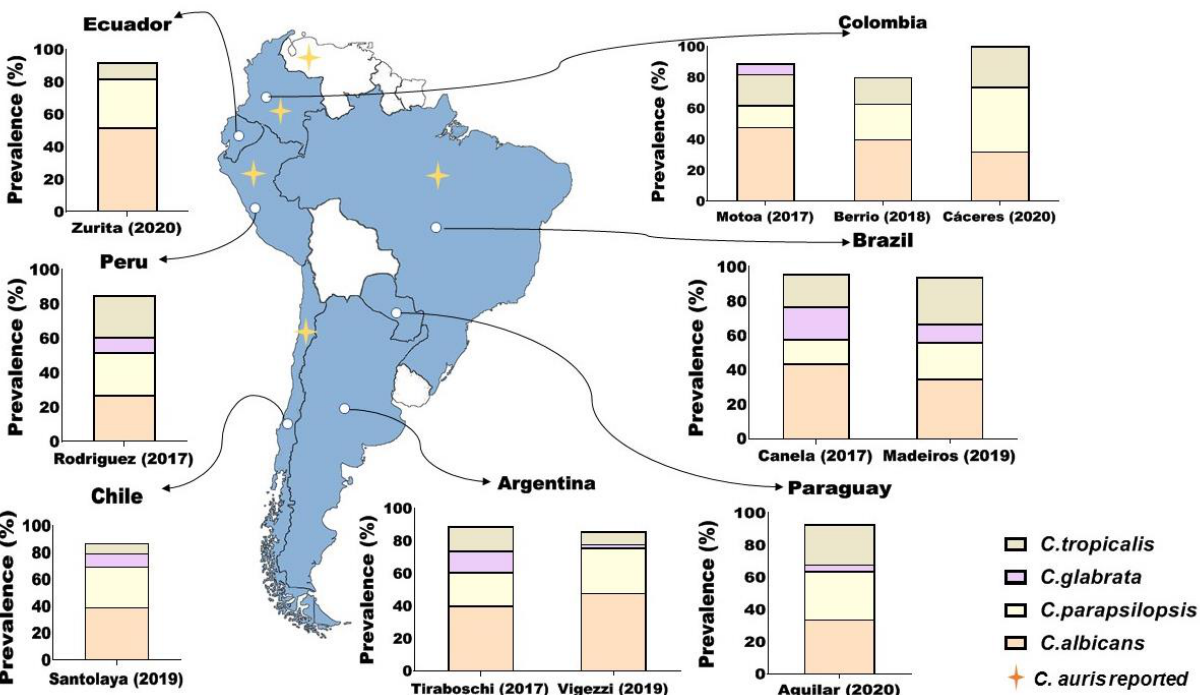
Figure 1. Epidemiology of candidemia in South America (2017 – 2022). Data about C. auris were recently published by the Pan American Health Organization (PAHO) [28]. Species distribution might have changed since these data were collected.